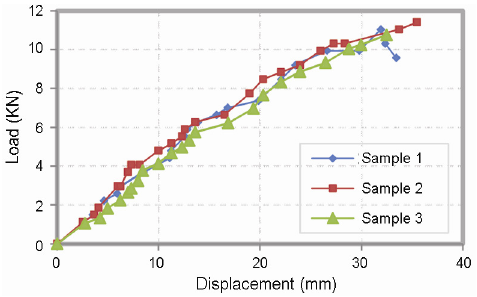
Fig. 16. Load-displacement curves for FRP-strengthened speci- mens with two layers of GFRP and with transverse grooves